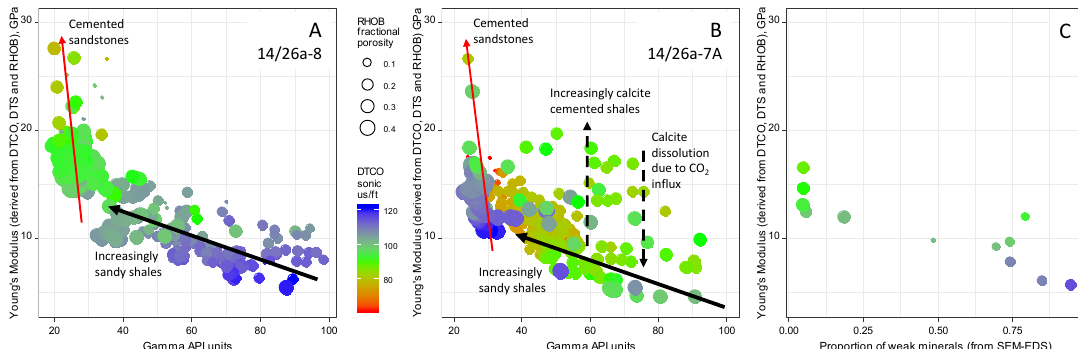
Figure 20. Comparison of clay mineral indicators to Young’s modulus indicator for the Rodby Formation. Diagram prepared using R-studio-ggplot2 software [15] . ( A ) Wireline log-derived Young’s modulus, derived for Rodby Shale data from 14/26a-8 via compressional and shear sonic log data and density log data, using Equations (9)–(11), defined in Rider and Kennedy [16] , plotted versus gamma ray log data with the data differentiated by density log-derived porosity and compressional sonic log data. The solid black arrow shows that decreasing shale gamma corresponds to higher Young’s modulus values; decreasing compressional sonic (DTCO) and porosity also lead to higher Young’s modulus. For reference, the red arrow corresponds to increasingly cemented sandstones that achieve ever higher Young’s modulus values. For a given shale gamma ray value (i.e., for a fixed clay mineral content), Young’s modulus increases as sonic and porosity values decrease as these represent more compact rock that may have a greater quantity of calcite (and see Figure 10). ( B ) Wireline log-derived Young’s modulus, derived for Rodby Shale data from 14/26a-7A, equivalent to the data in Figure 20A. The solid black and red arrows reveal the same patterns as in 14/26a-8; the dashed black arrows show that some part of the Rodby in this well (lithology proven by high gamma) have relatively high Young’s modulus, but these intervals have a slightly lower porosity and have lower sonic values, demonstrating that these shales have undergone localised cementation (probably by calcite). There are no equivalent data for the two Lista wells, since shear sonic (DTS) logs were not taken. ( C ) Wireline log-derived Young’s modulus, derived for Rodby Shale data from 14/26a-8, using the same method as part A [16] , compared to the SEM-EDS-derived proportion of weak minerals (sum of all clay minerals). Although there are clearly fewer data in part C, it displays the same overall pattern as parts A and B. This figure suggests that it may be possible to predict Young’s modulus (rock strength) for shale, based on gamma, density, and compressional sonic logs, even when shear sonic log data are not available.